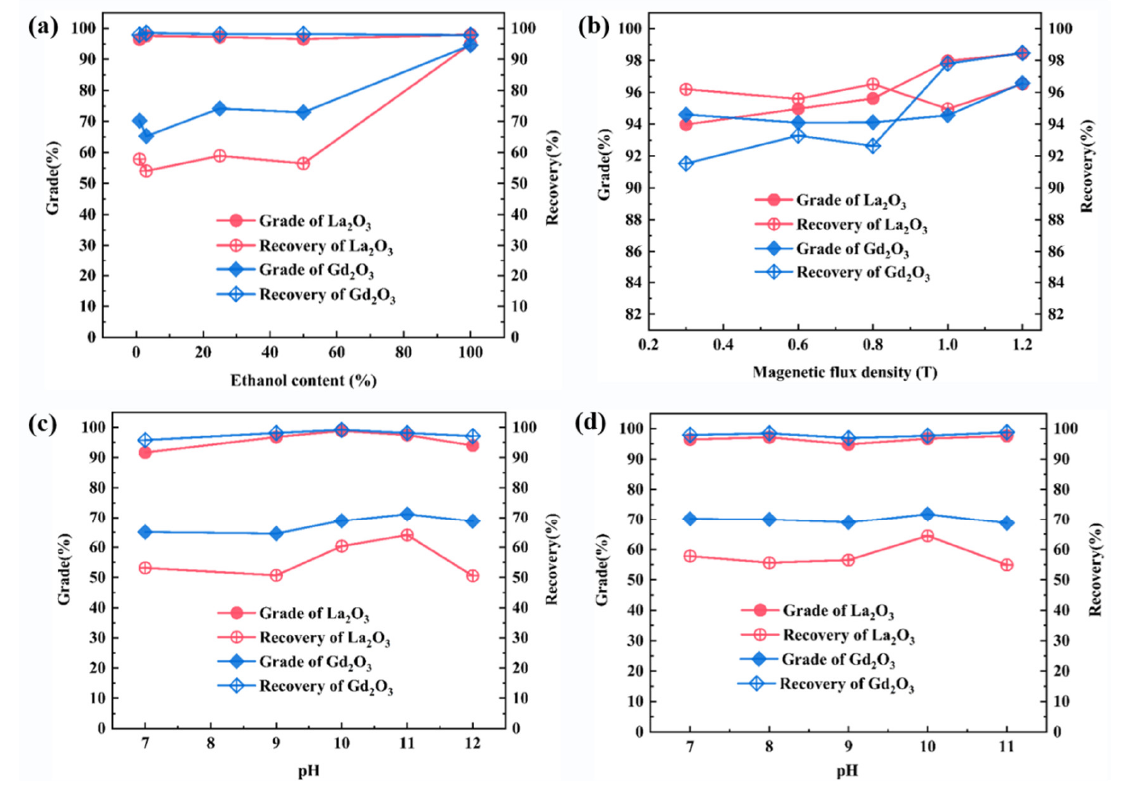
Figure 5. Results of HGMS ( a ) different ethanol content, ( b ) absolute ethanol at different field strengths, ( c ) pure water at different pH, and ( d ) 1% ethanol at different pH.